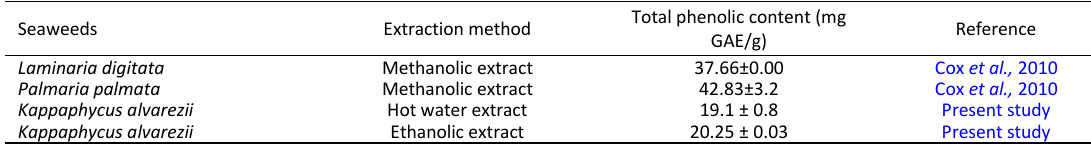
Fig. 1: Gallic acid standard curve (R 2 =09889) Table 2: Total phenolic content of Kappaphycus alvarezii (mg GAE/g of extract) Seaweeds